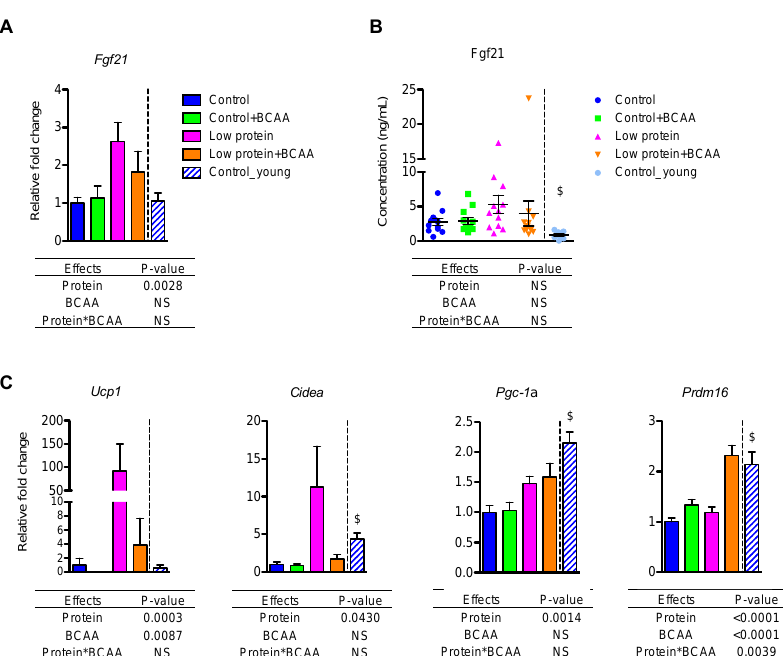
Figure 3. Low protein diet upregulated Fgf21 mRNA in the liver and thermogenic gene expression in inguinal white adipose tissue (IWAT). The liver mRNA expression of Fgf21 ( A ) and plasma FGF21 concentrations ( B ) were measured. The mRNA expression of Ucp1, Cidea, Pgc-1 α , and Prdm16 was measured in IWAT ( C ). Data represent mean ± SEM ( n = 8 – 12 mice/group). Statistical analyses of main effects (protein and BCAA) and interactions (protein*BCAA) are shown below each graph. $ p < 0.05 for young vs. old control groups.